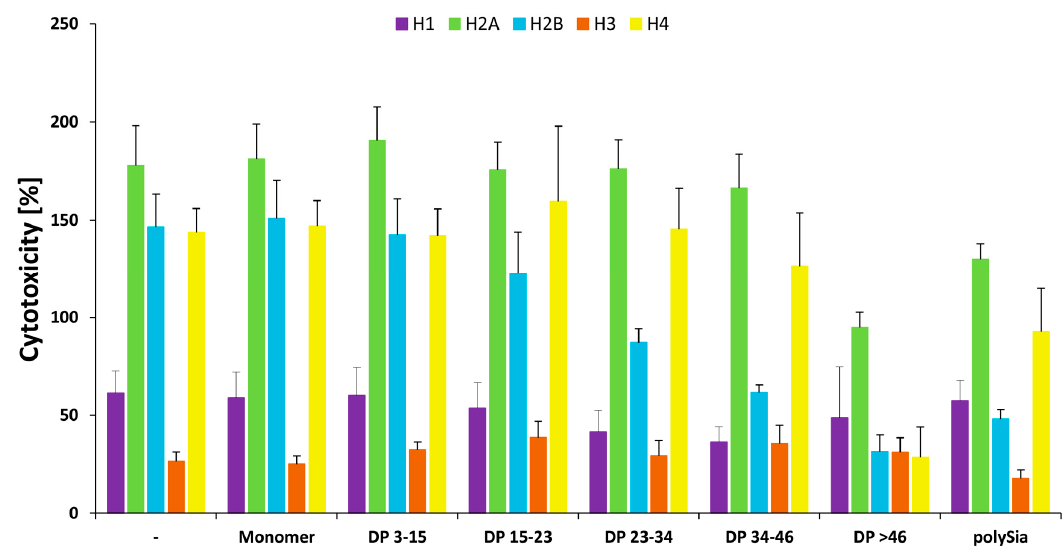
Figure 8. Summary of polySia’s influence on all histones in comparison to a mixture of all histones. In contrast to Figure 7 histone-mix mediated cytotoxicity was set to 100% and compared with all individual histones. All experiments were performed three times independently.